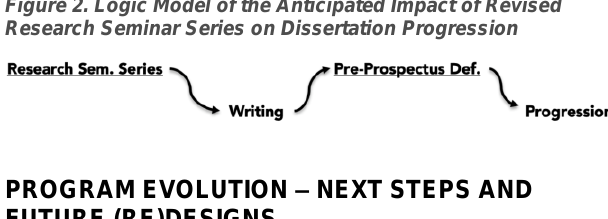
PROGRAM EVOLUTION – NEXT STEPS